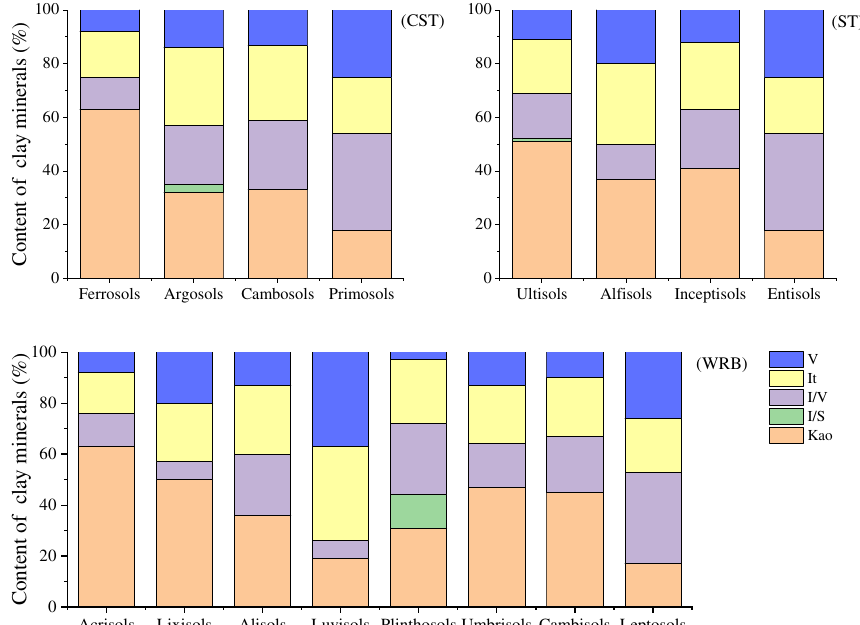
Figure 7. Relative contents of clay minerals of different soil types (i.e., soil orders) (Kao: kaolinite; It: illite; V: vermiculite; I/S: illite/smectite mixed-layer mineral; I/V: illite/vermiculite mixed-layer mineral; CST: Chinese Soil Taxonomy; ST: Soil Taxonomy; WRB: World Reference Base for Soil Resources).